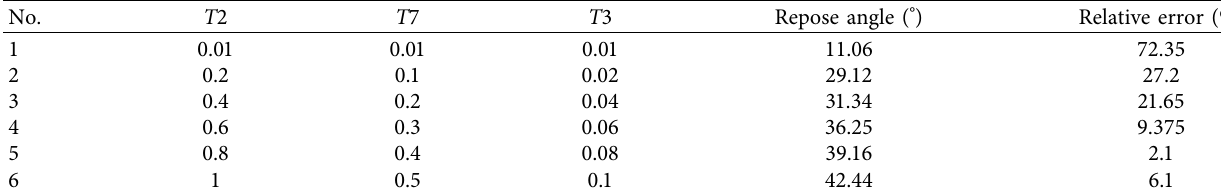
Table 5: Results of steepest ascent test.